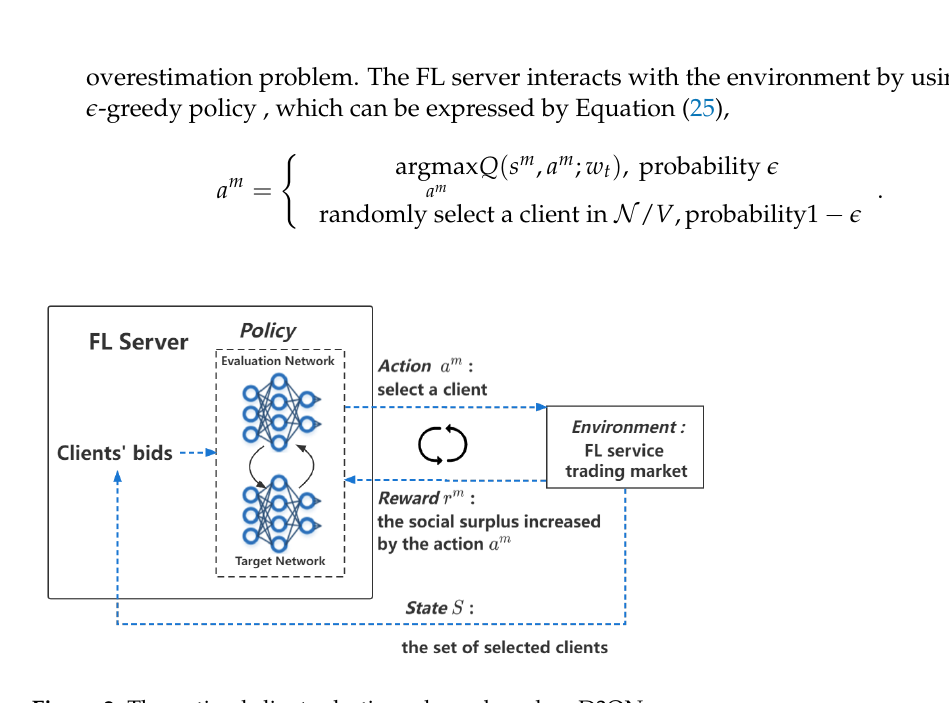
Figure 2. The optimal client selection scheme based on